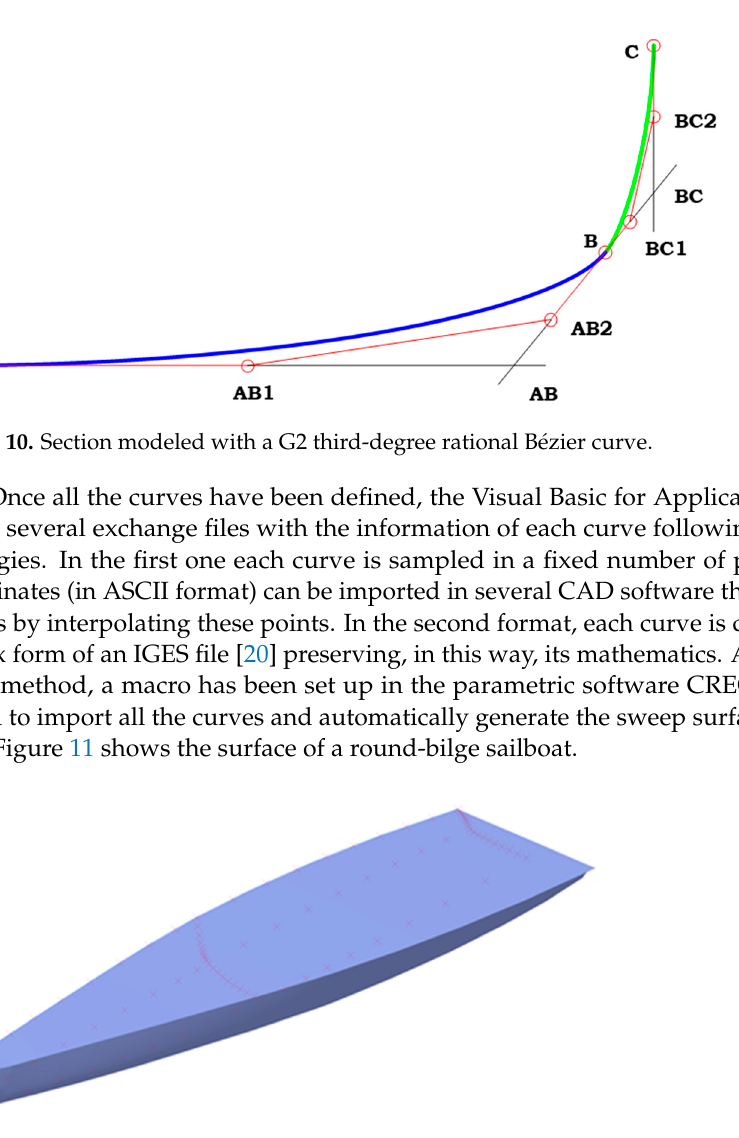
Figure 9. Control polygon of a G1 second-degree rational Bézier curve.